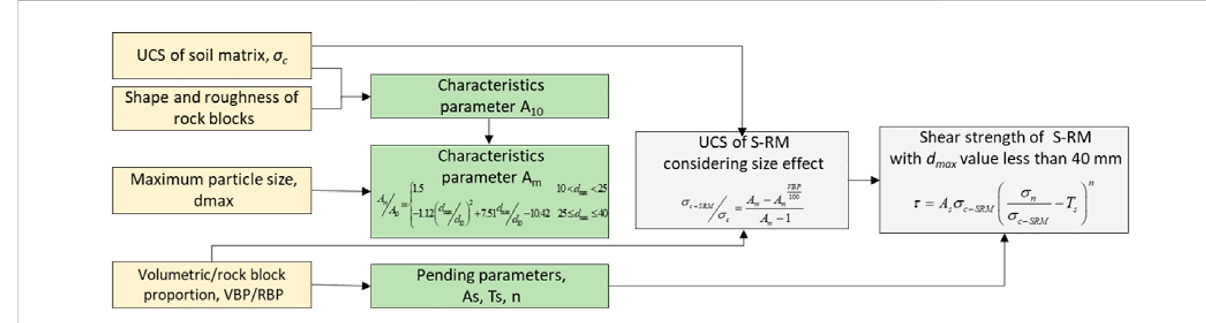
FIGURE 11 Flow chart of the shear strength determination method of S-RM considering size effect.